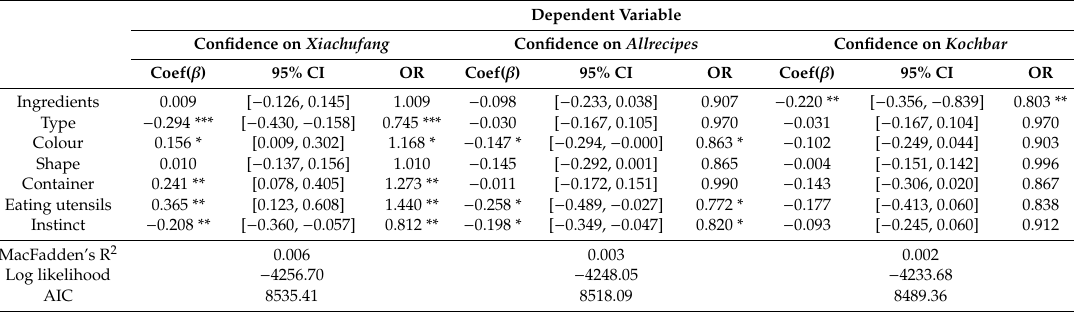
Table 7. Ordinal regression models predicting participant confidence for images associated with each recipe